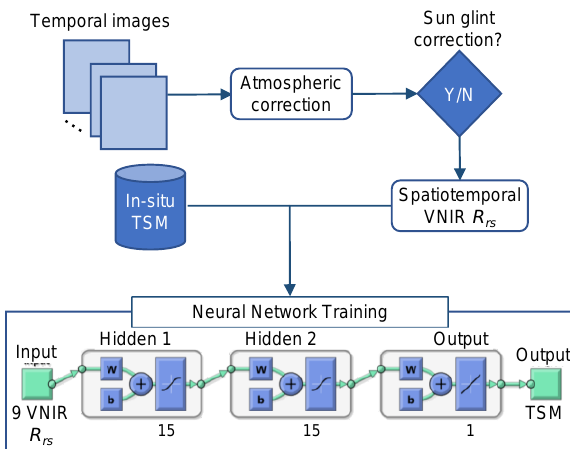
Figure 1 . A thematic representation of the proposed machine learning approach for retrieving